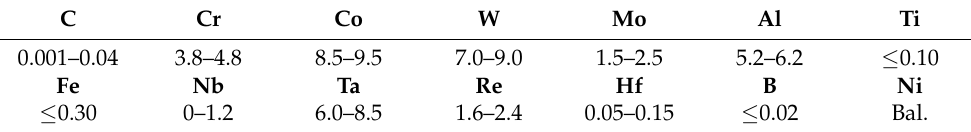
Table 1. Nominal composition of DD6 superalloys (mass